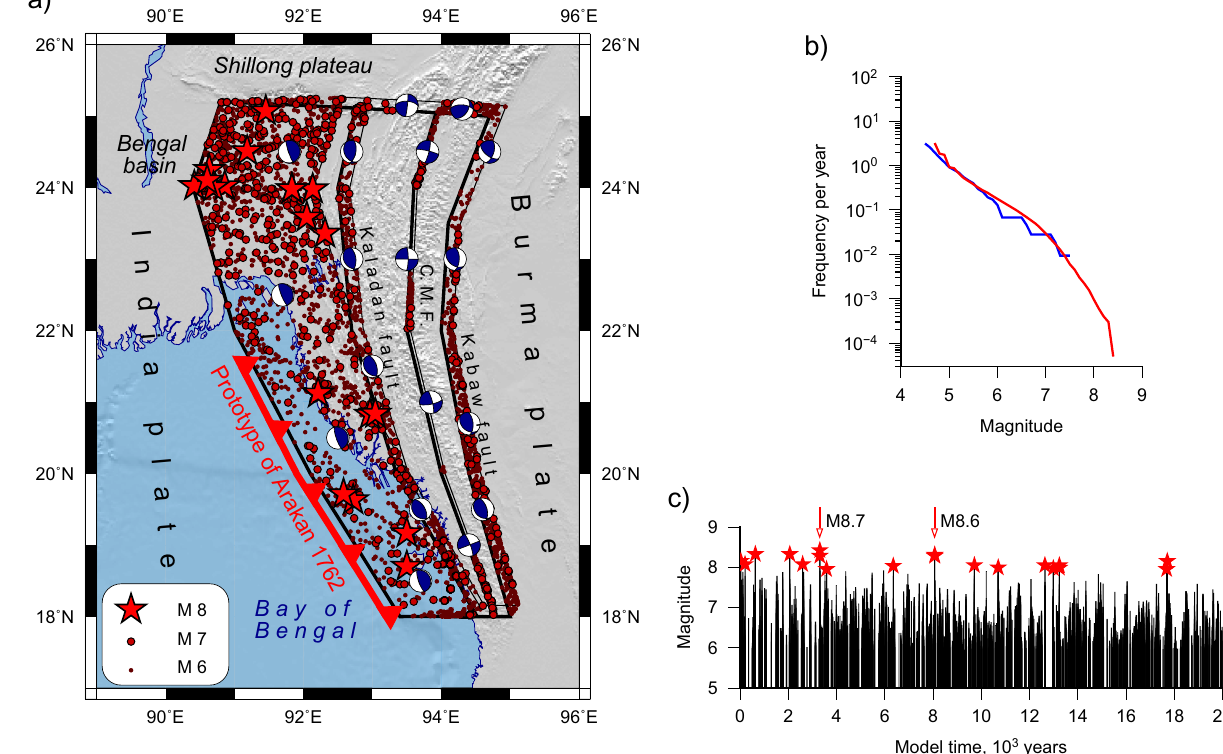
Figure 4. Overview of synthetic seismicity simulated for 20 thousand years by the preferred model “All faults locked”. ( a ) The map of epicenters: all great earthquakes with M ≥ 8 (red stars) are simulated in the India-Burma Detachment (IBD); beach balls are synthetic FPS. ( b ) Earthquake size distribution (frequency per year) for the synthetic (red) and recorded (blue) seismicity. ( c ) Time sequence of synthetic M6+ earthquakes. The rupture zone of two multi-segment giant M8.7 and M 8.6 earthquakes is marked by red thrust line in ( a ), and by arrows in ( c